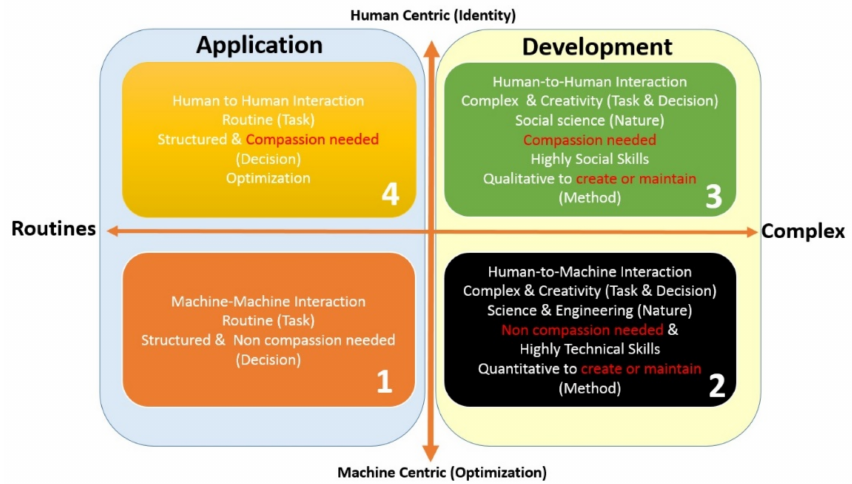
Figure 1. Job Matrix Format Fourth Industrial